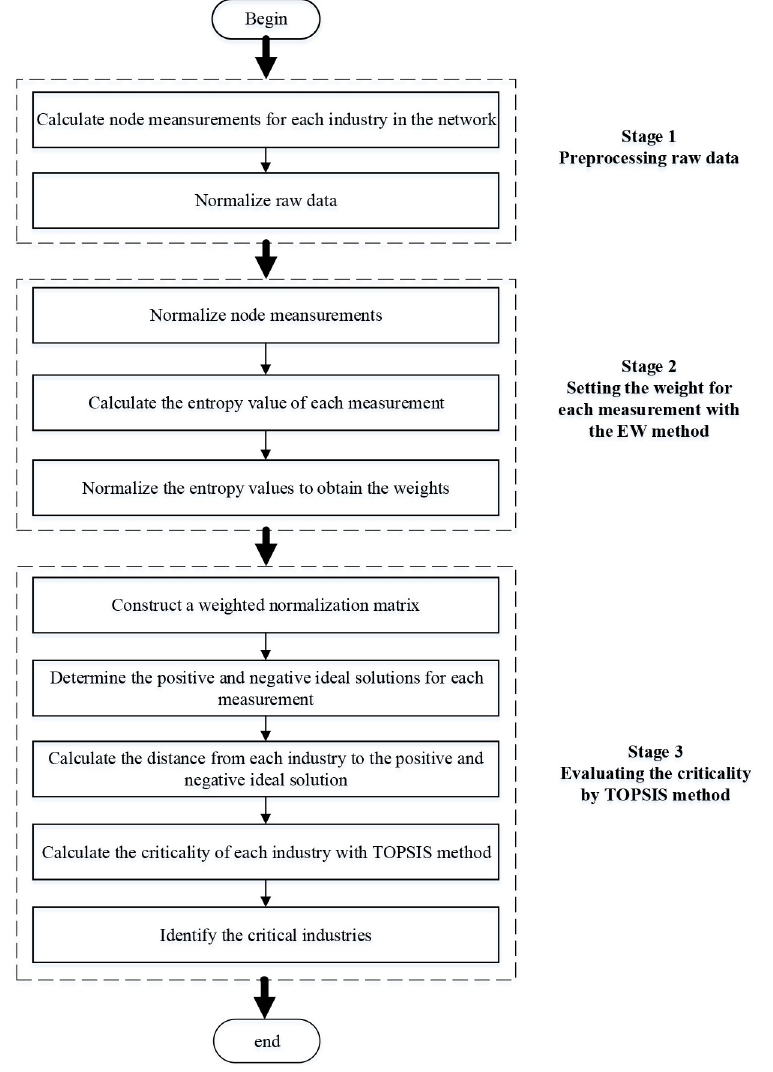
Fig 1. The procedure of the integrated method for industrial